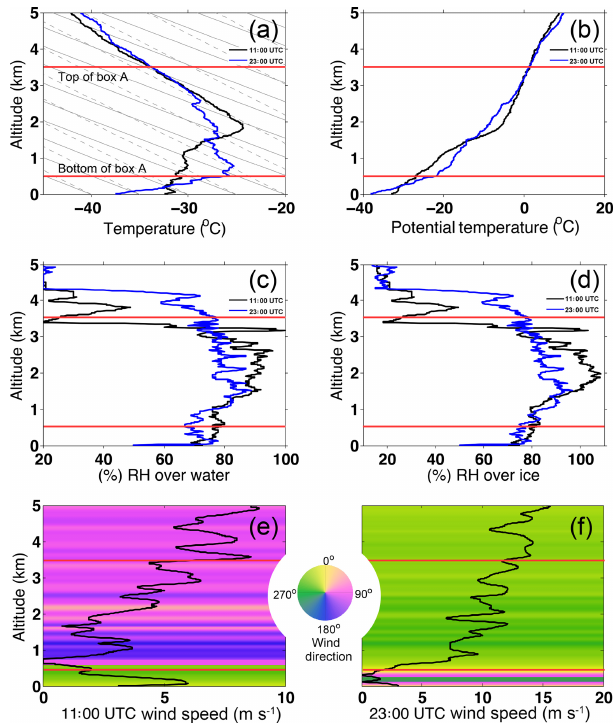
Figure 7. 14 November 2017; (a–f) same format as Fig. 5. Red lines show top and bottom altitudes of Box A from Fig.